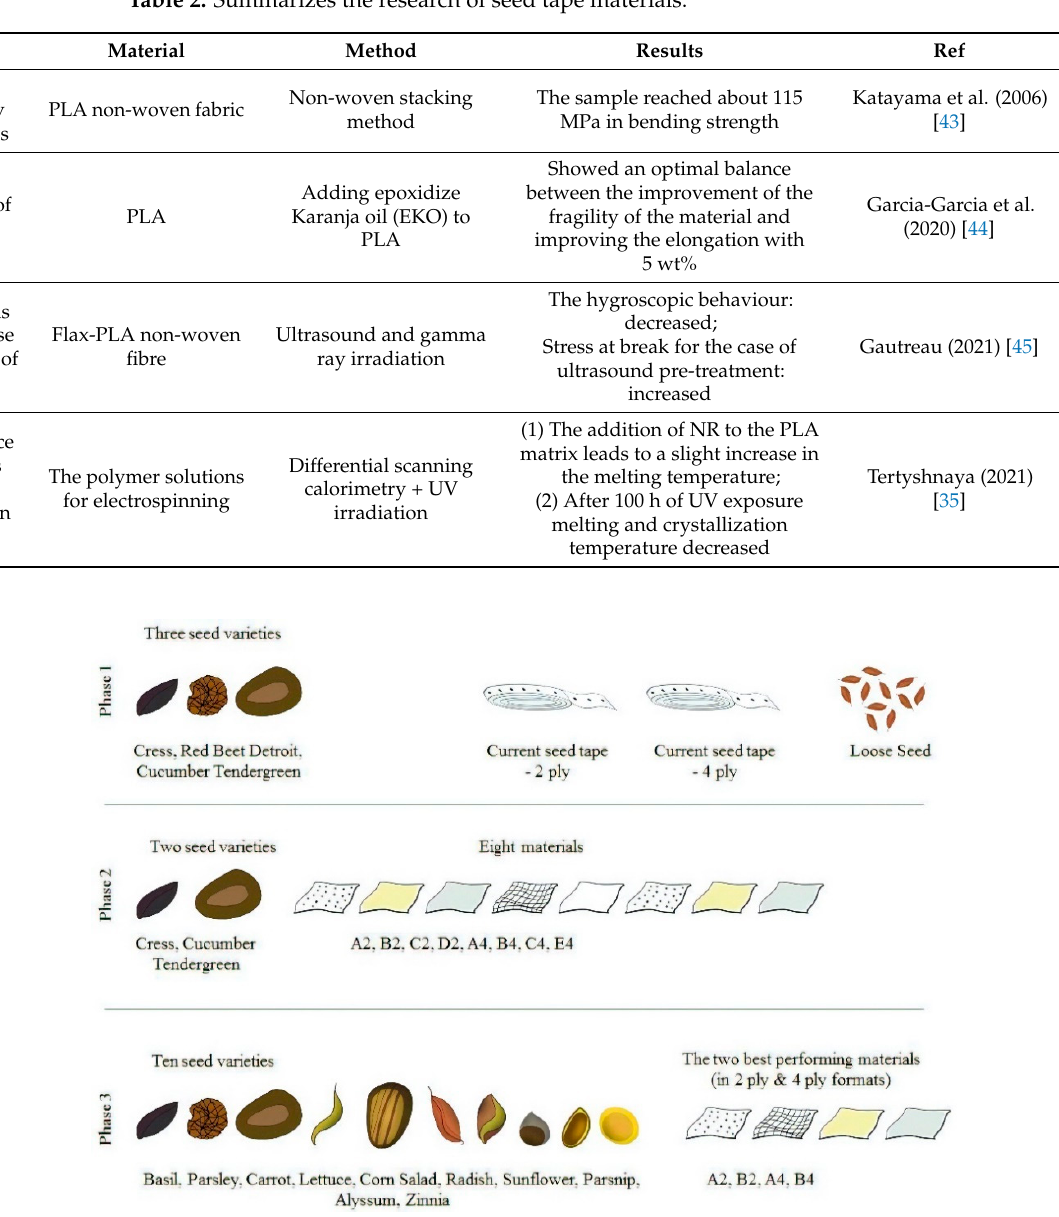
Table 2. Summarizes the research of seed tape materials.